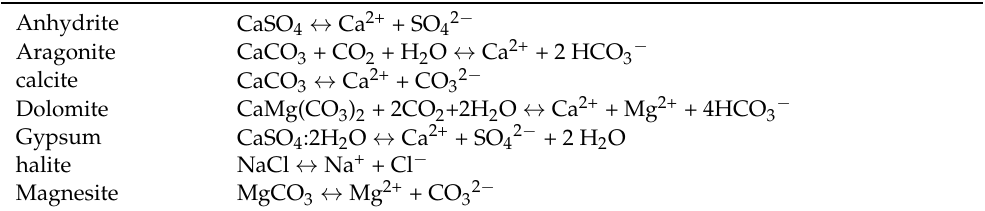
Table 1. Dissolution process of calcareous